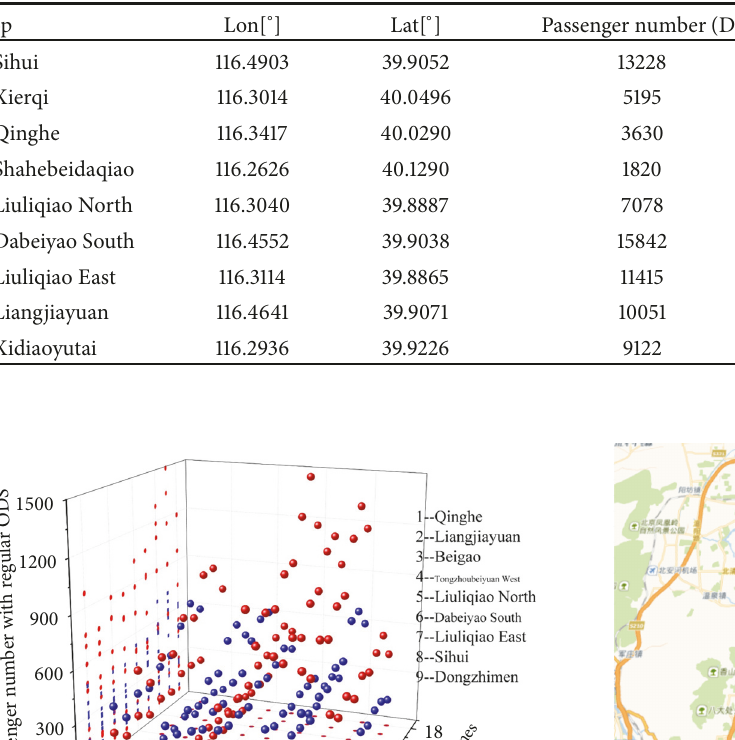
Table 1: Detail data for the top five origin stops and destination stops with the most passengers in the morning.